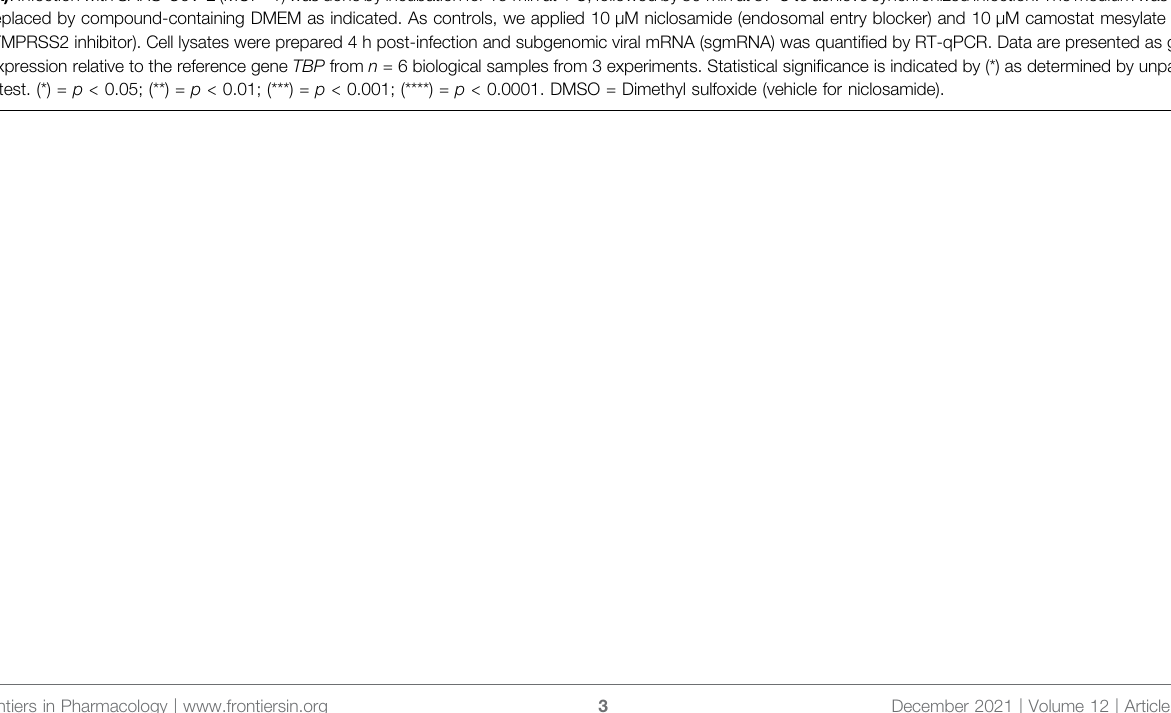
Frontiers in Pharmacology |